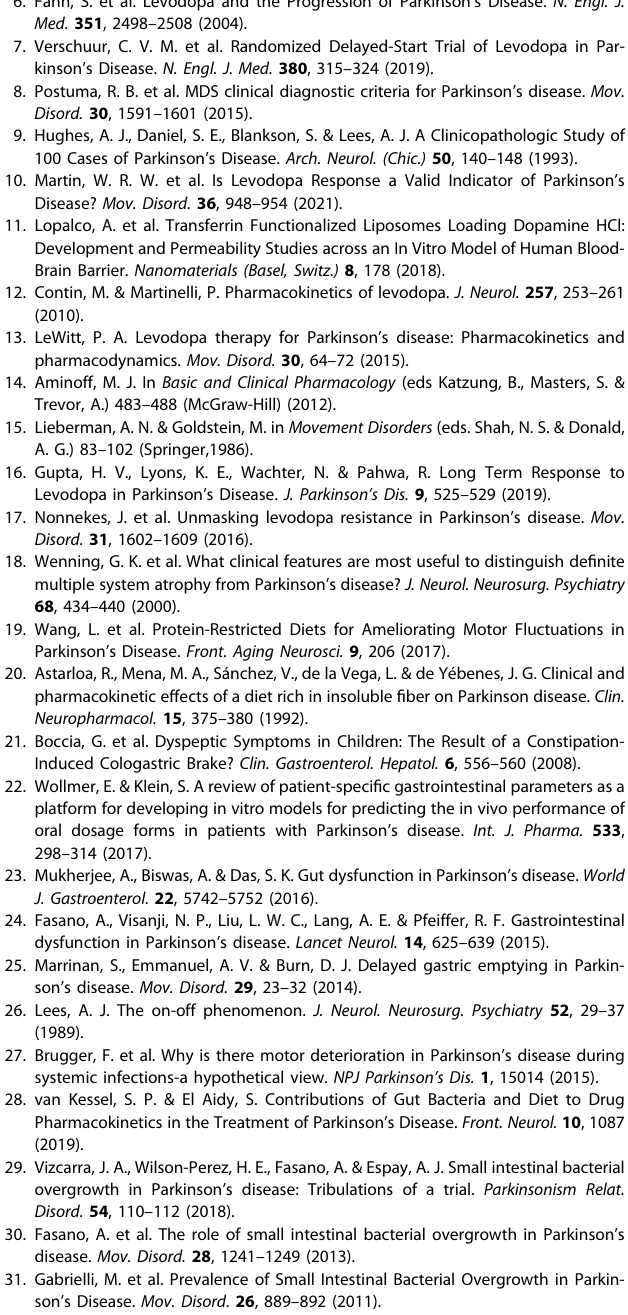
Fig. 4 Flowchart detailing a possible diagnostic and treatment approach to suspected levodopa non-response. a/c See Postuma et al 8 . b Rule out insuf fi cient dosing, trial a dosage increase, consider add-on therapy for symptomatic relief of dose-limiting side effects (e.g., domperidone for peripheral dopaminergic effects such as nausea, amantadine for dyskinesias) - Is the resistant symptom known to be less- responsive to dopaminergic medication (axial symptoms, tremor)? - Rule out & treat underlying gastroparesis and constipation - Check for, and phase out, dopamine receptor blocking or dopamine depleting co-medication. d At least 600 mg levodopa/day during at least 1 month 8 . e Bloating, constipation, excessive fl atulence and/or diarrhea. f Such as residual in fl ammation of intestinal lining despite SIBO treatment, delayed gastric emptying. g Using oral dopamine receptor agonists. h If no effect, consider wrong diagnosis (primary non-response) or severe nigrostriatal degeneration in the context of disease progression (secondary non-response). Non-pharmacological therapy includes paramedic care and deep brain stimulation in case of symptoms that may respond better to DBS than to dopaminergic medication (tremor, dystonia, dyskinesia). PD Parkinson ’ s disease, MDS-CDC Movement Disorder Society Clinical Diagnostic Criteria for Parkinson ’ s Disease, SIBO small- intestinal bacterial